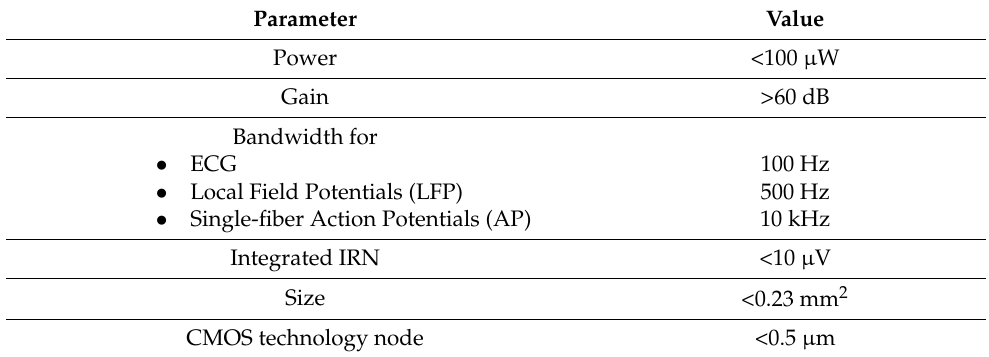
Table 1. Typical parameters for biomedical amplifiers on a per-channel basis in systems with a large number of parallel